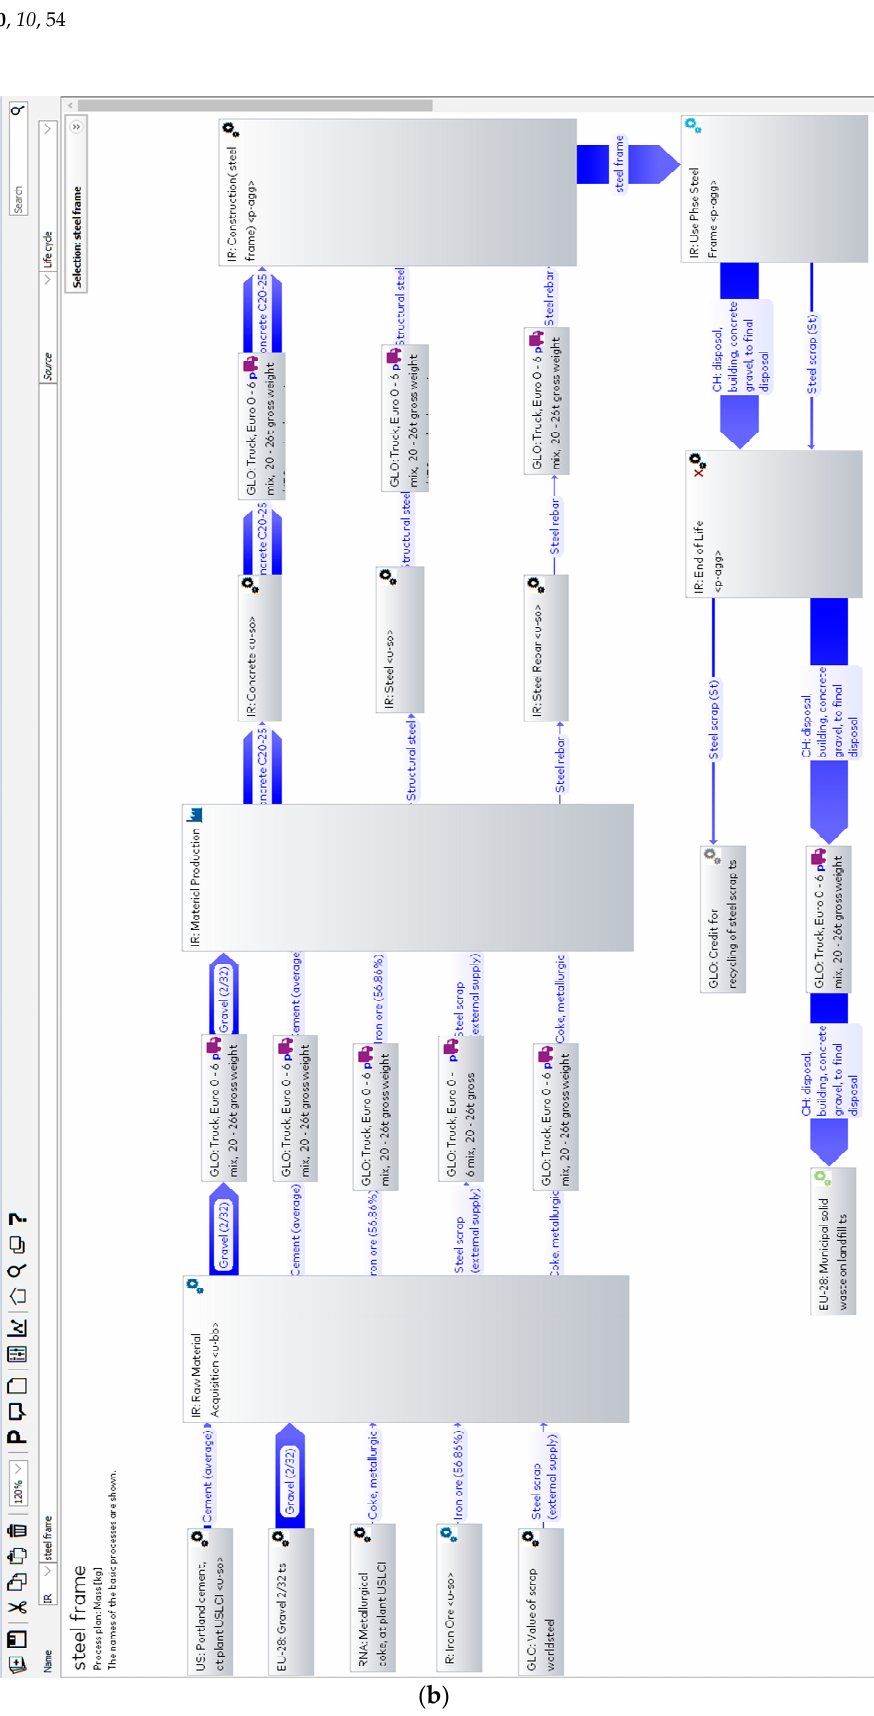
Figure 5. GaBi life cycle assessment (LCA) processes: ( a ) concrete building and ( b ) steel building.